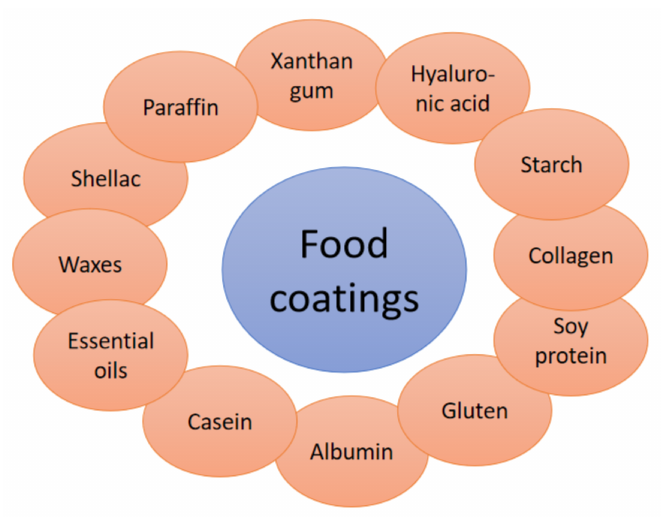
Figure 5. Most popular biopolymers in food